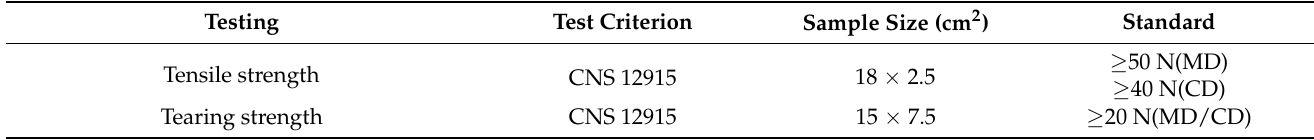
Table 2. Specifications of samples required by test